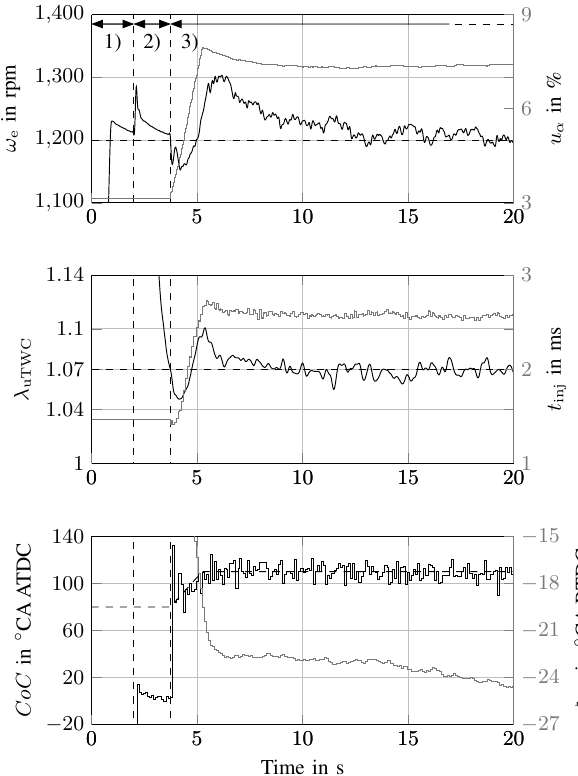
Figure 6. Actuator and control signals during the warm-up phase. Dashed black marker at 2 s: opening of the clutch. Dashed black marker at around 3.5 s: starting of feedback control. The engine speed signal ω e is low-pass filtered with a cut-off frequency slightly lower than the engine segment frequency such that oscillations due to the individual combustion events are filtered. All other signals are presented in their raw